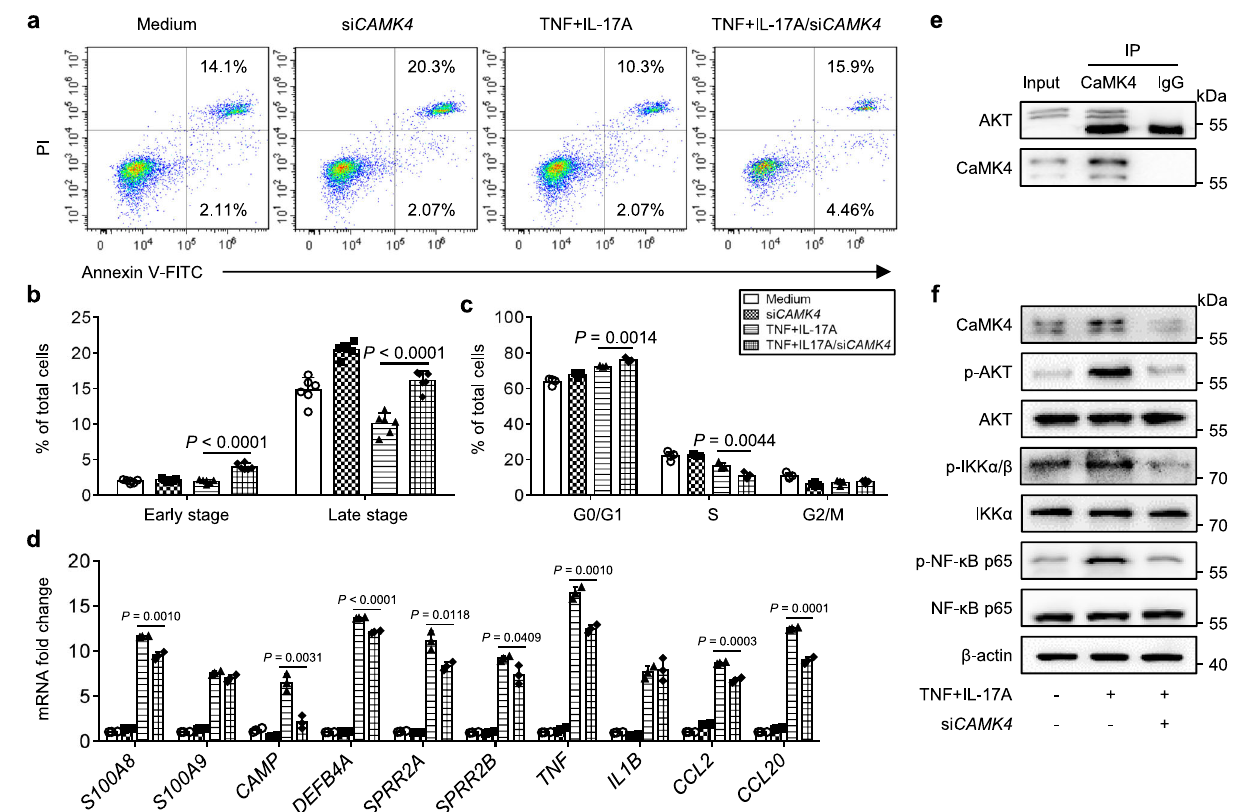
Fig. 8 | The CaMK4-AKT-NF- κ B pathway promotes KC pro-in fl ammatory phe- notypes. HaCaTcellsweretransfectedwithsi CAMK4 orscrambledcontrolfor24h. ThenthecellswerestimulatedwithrecombinanthumanTNF(50ng/ml)andIL-17A (50ng/ml) for 24h. The cells were harvested for analyses of apoptosis, cell cycle, and gene and protein levels. a Representative fl ow cytometry plots of HaCaT cell apoptosis. b The proportions of early and late apoptotic cells ( n =6 biologically independent samples). c Statistical analysis of G0/G1, S, and M phases of cell cycle